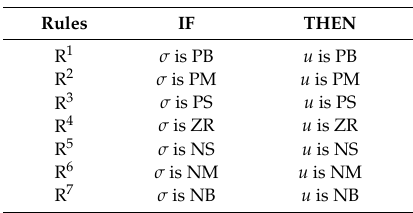
Table 2. Fuzzy Rules.